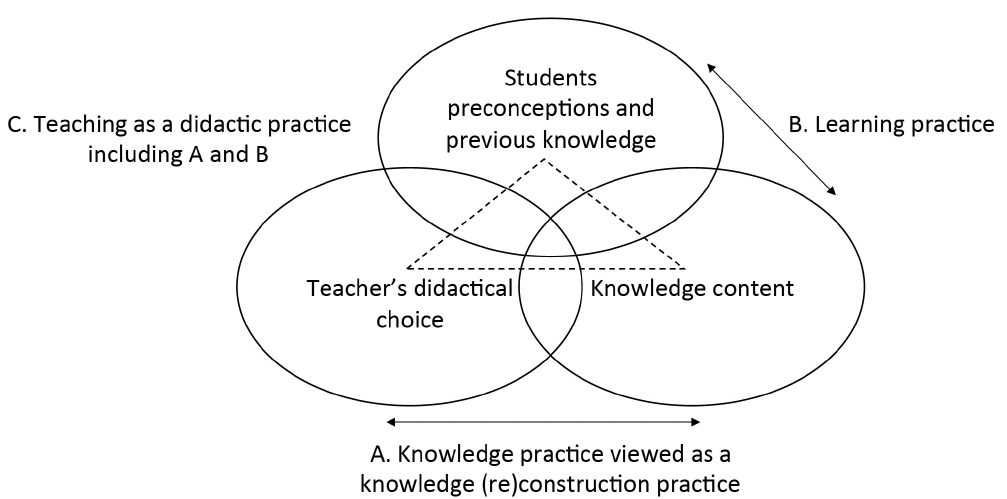
Figure 2: Model of the teacher’s didactic practices: Selection of content at the classroom level (drawing on Carlgren,